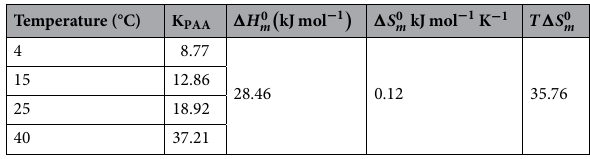
Table 5. Molar standard thermodynamic of partitioning of PAA.